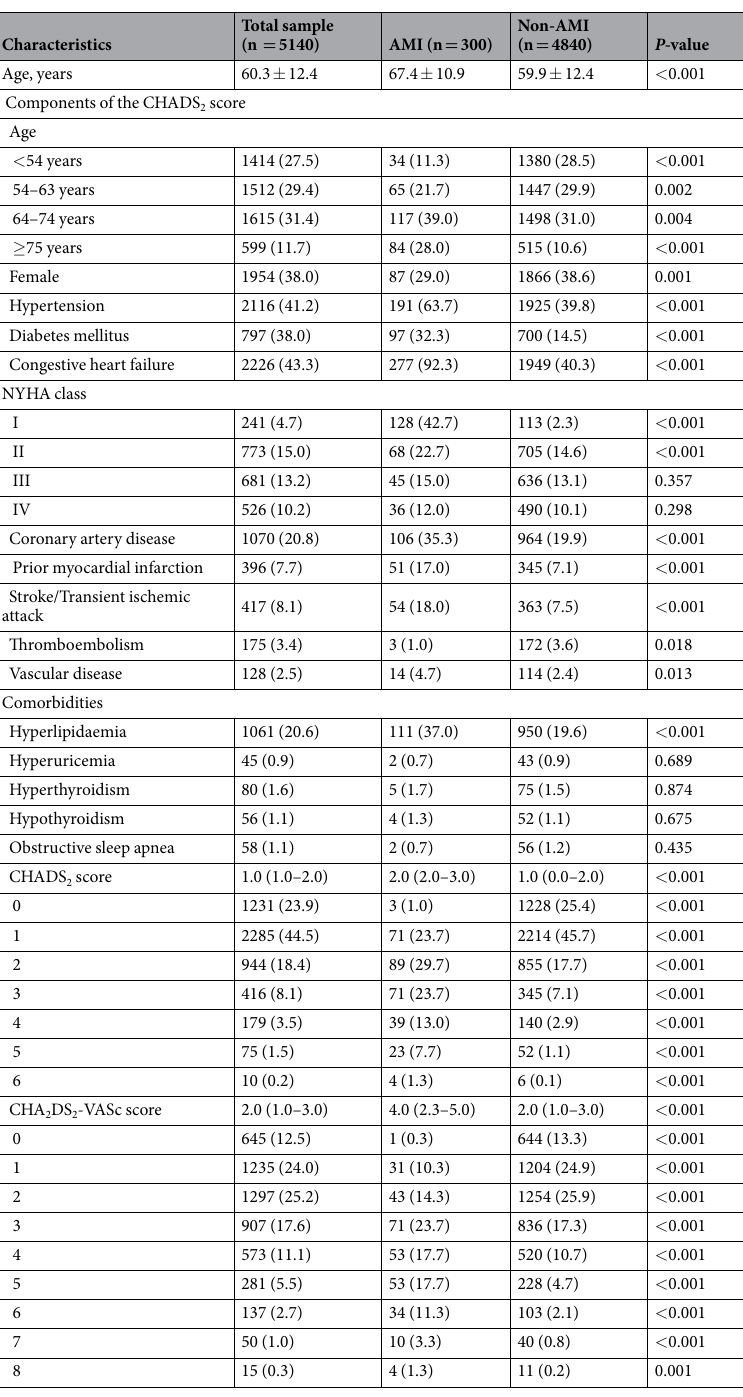
Table 1. Characteristics of the study population. Data given as mean ± SD, n (%) or median (IQR). Abbreviations: AMI, acute myocardial infarction. NYHA, New York Heart